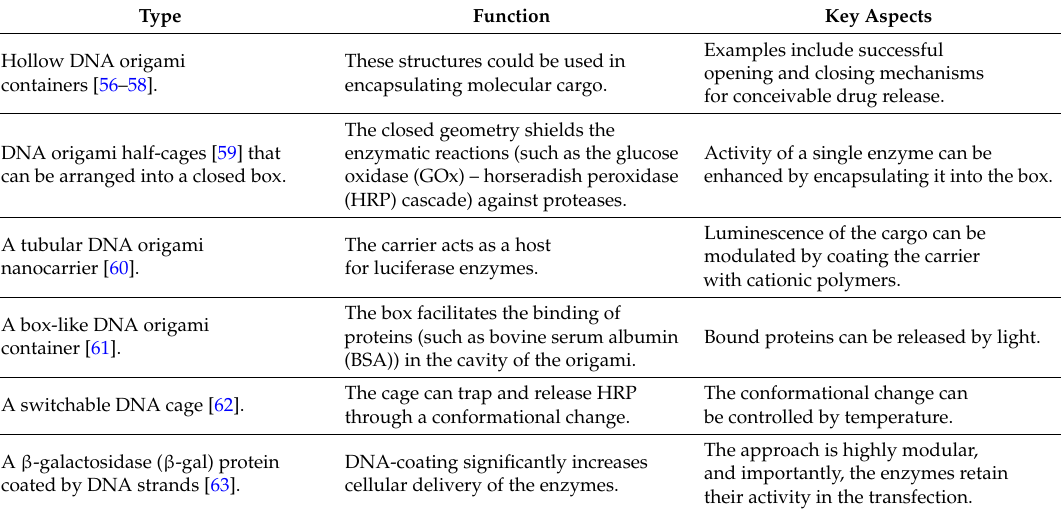
Table 3. Examples of DNA-based enzyme containers and